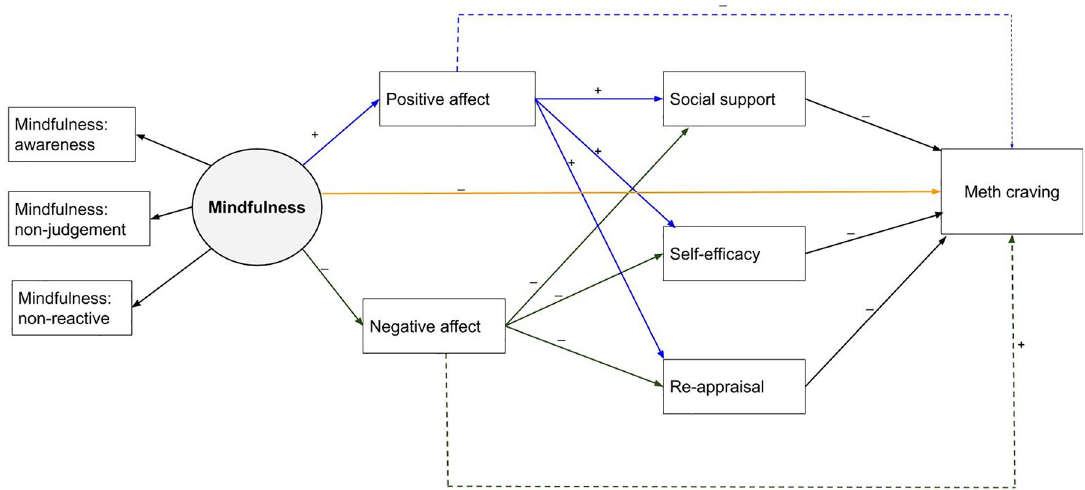
Fig 1. Theoretical pathways linking dispositional mindfulness to methamphetamine